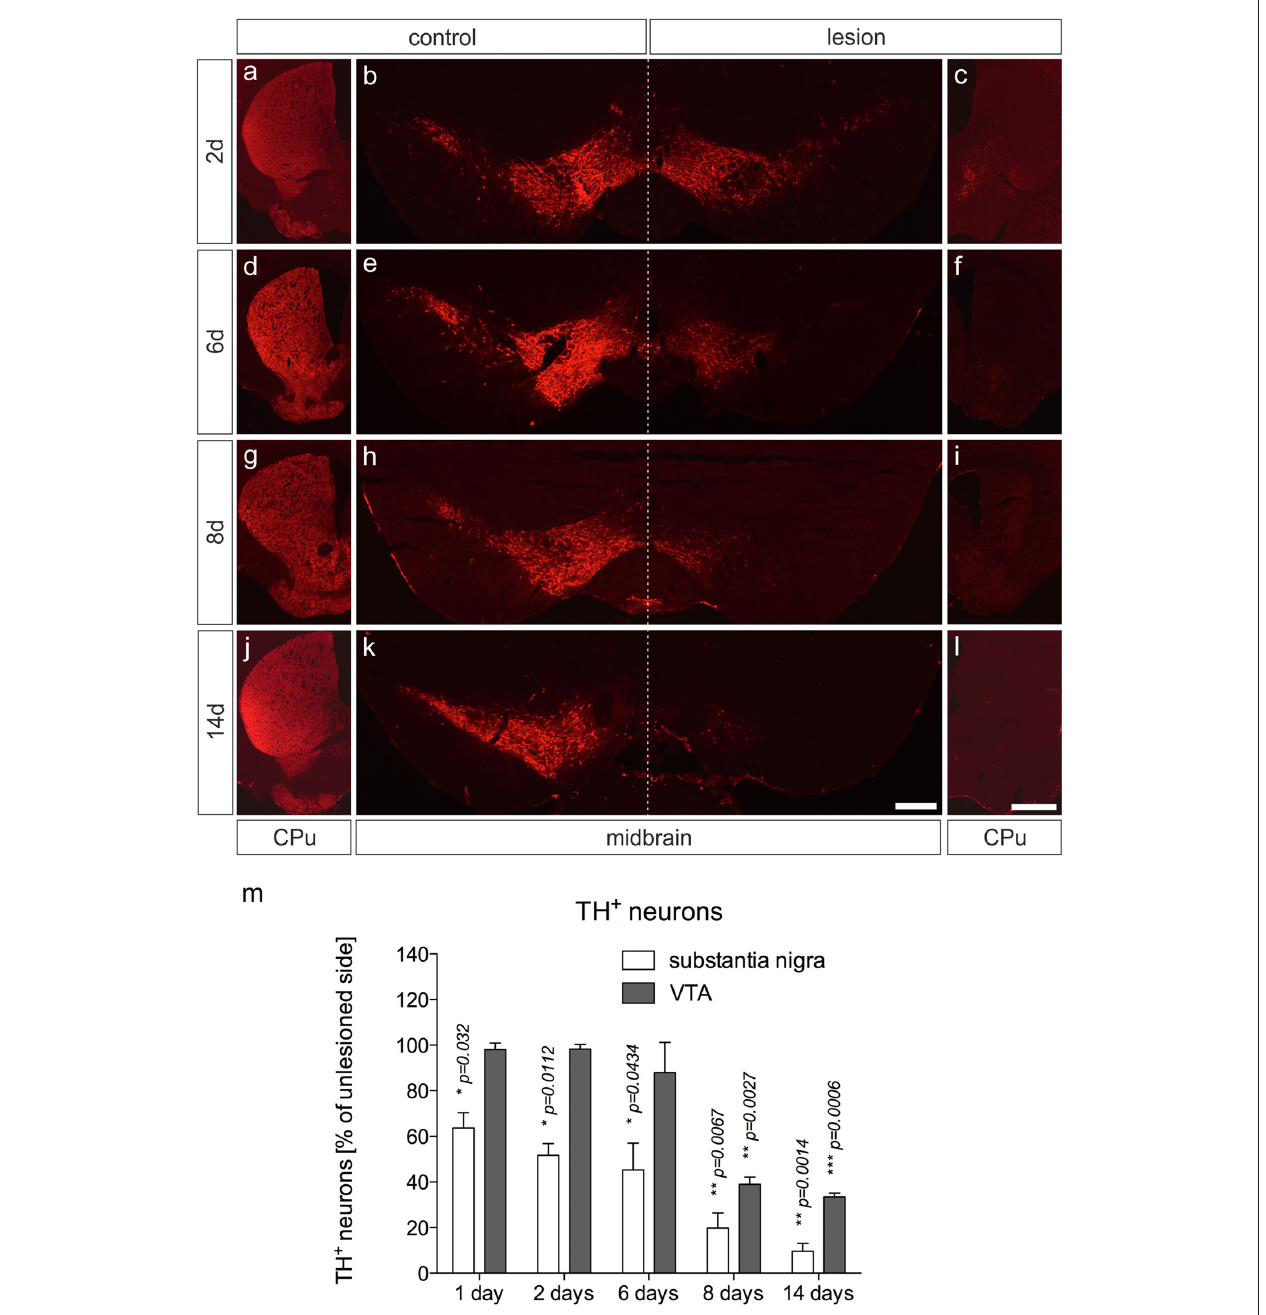
FIGURE 1 | 6-OHDA injections into the MFB induce robust loss of mDA neurons and denervation in the CPu on the lesioned side. Coronal brain sections after immunohistochemistry for TH from CPu and ventral midbrains containing SN and VTA are shown 2 days (A–C) , 6 days (D–F) , 8 days (G–I) and 14 days (J–L) after 6-OHDA injections. Whereas loss of TH + fibers in the CPu occurs from 2 days onwards, substantial decrease in numbers of TH + mDA neurons was evident after 6 days. Representative images from three independent experiments are shown. Scale bars indicate 300 µ m (B,E,H,K) and 1 mm for all CPu images. Quantification of SN and VTA TH + mDA neurons revealed significant decreases in SN neurons at all time-points analyzed. However, decrease of VTA neurons was delayed and reached significant differences at 8 days and 14 days (M) . Data are given as percentages from unlesioned sides ± SEM from three animals.